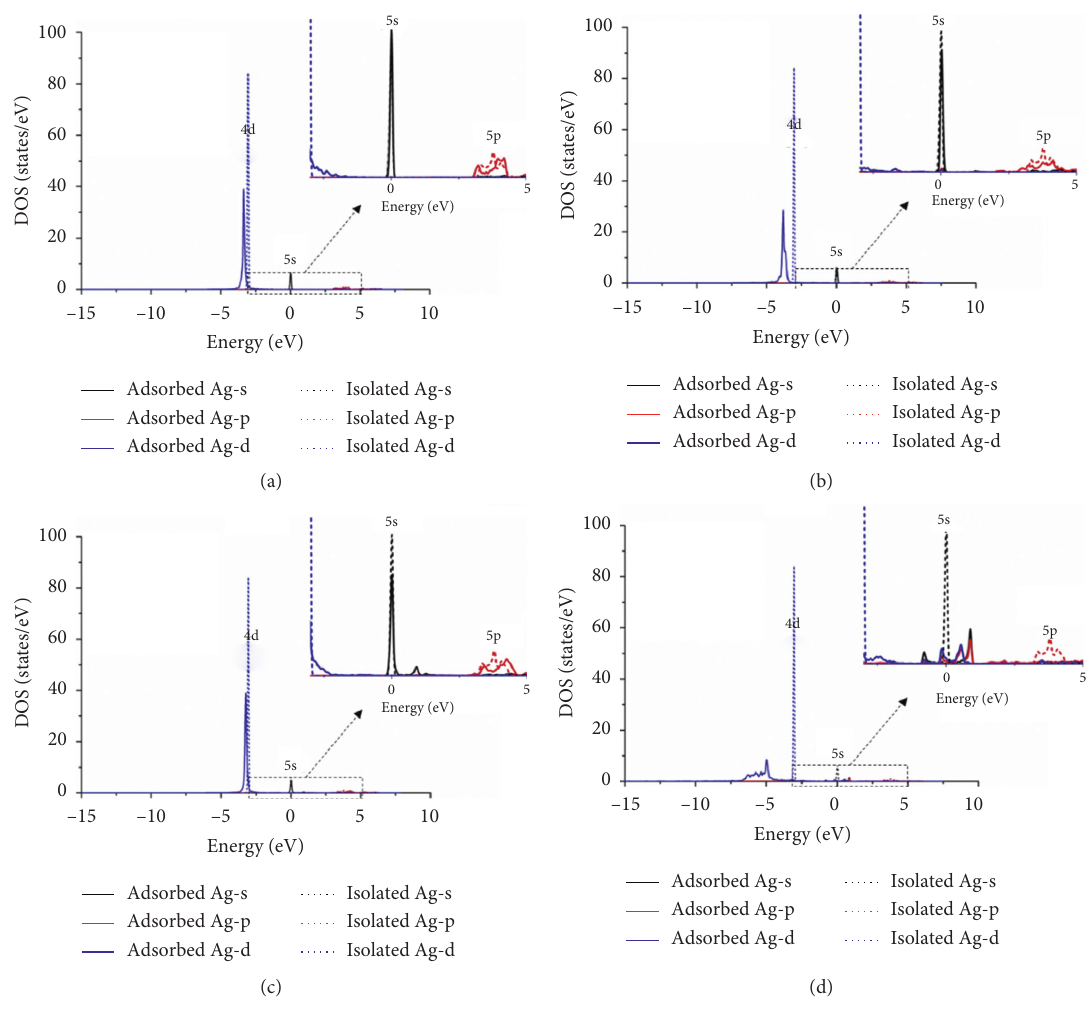
Figure 9: The DOS for isolated Ag atom (dashed line) and Ag adsorbed on matrix graphite surface (solid line): (a) perfect matrix graphite surface; (b) “bridge” interstitial defect; (c) “spiro” interstitial defect; (d) single vacancy defect. The energy is relative to Fermi level ( E f ) at E �